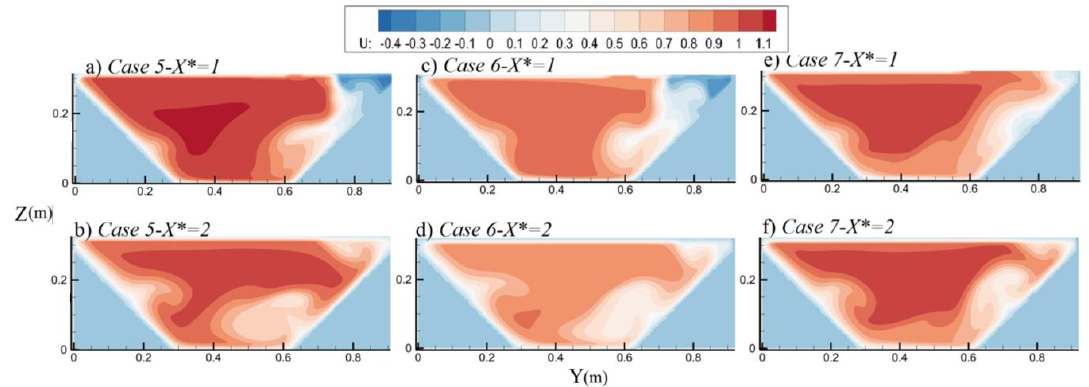
Figure 12. The effect of variations in W* and q* on the distribution of (U) in the transverse planes in the trapezoidal channel.